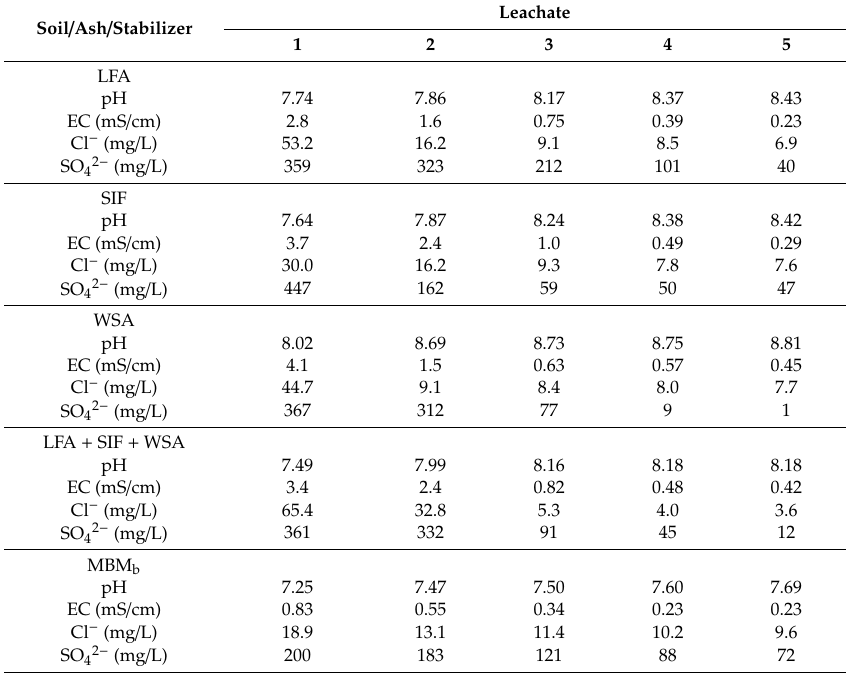
Table 4. Variation of pH, EC and ions in the leachates of soil / ash with 10% w / w stabilizers.